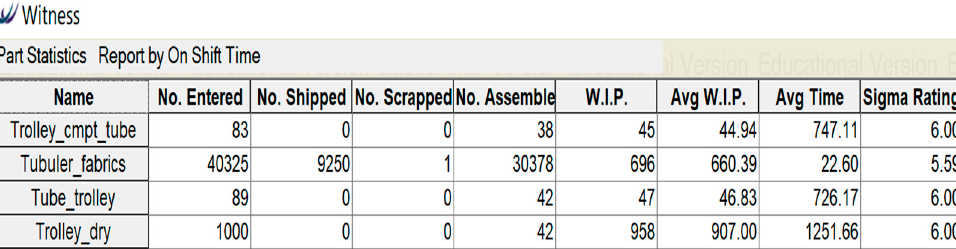
Figure 4. Map of the tubular fabric process in the WITNESS Horizon simulation platform.